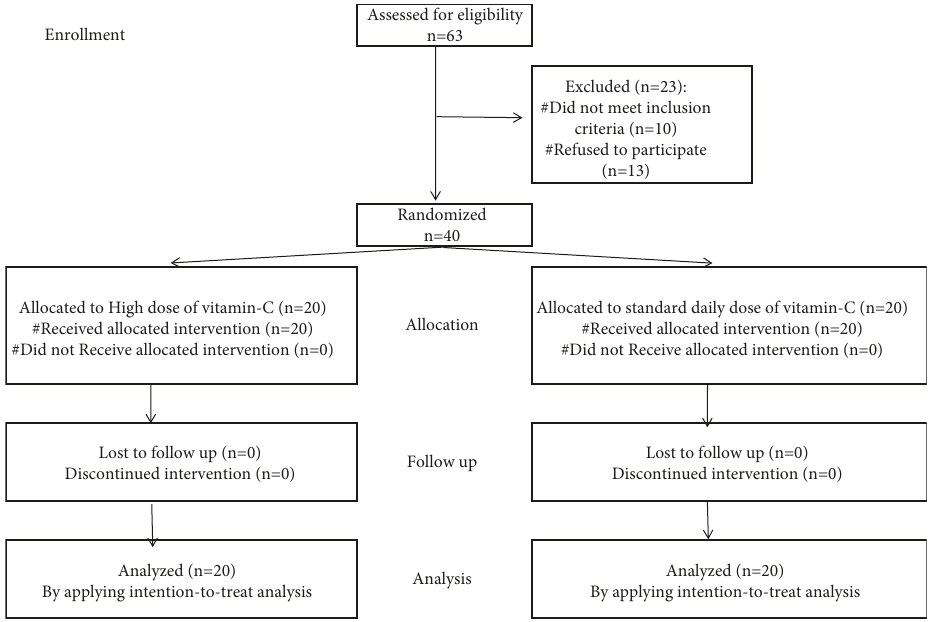
Figure 1: Flow diagram of the study.